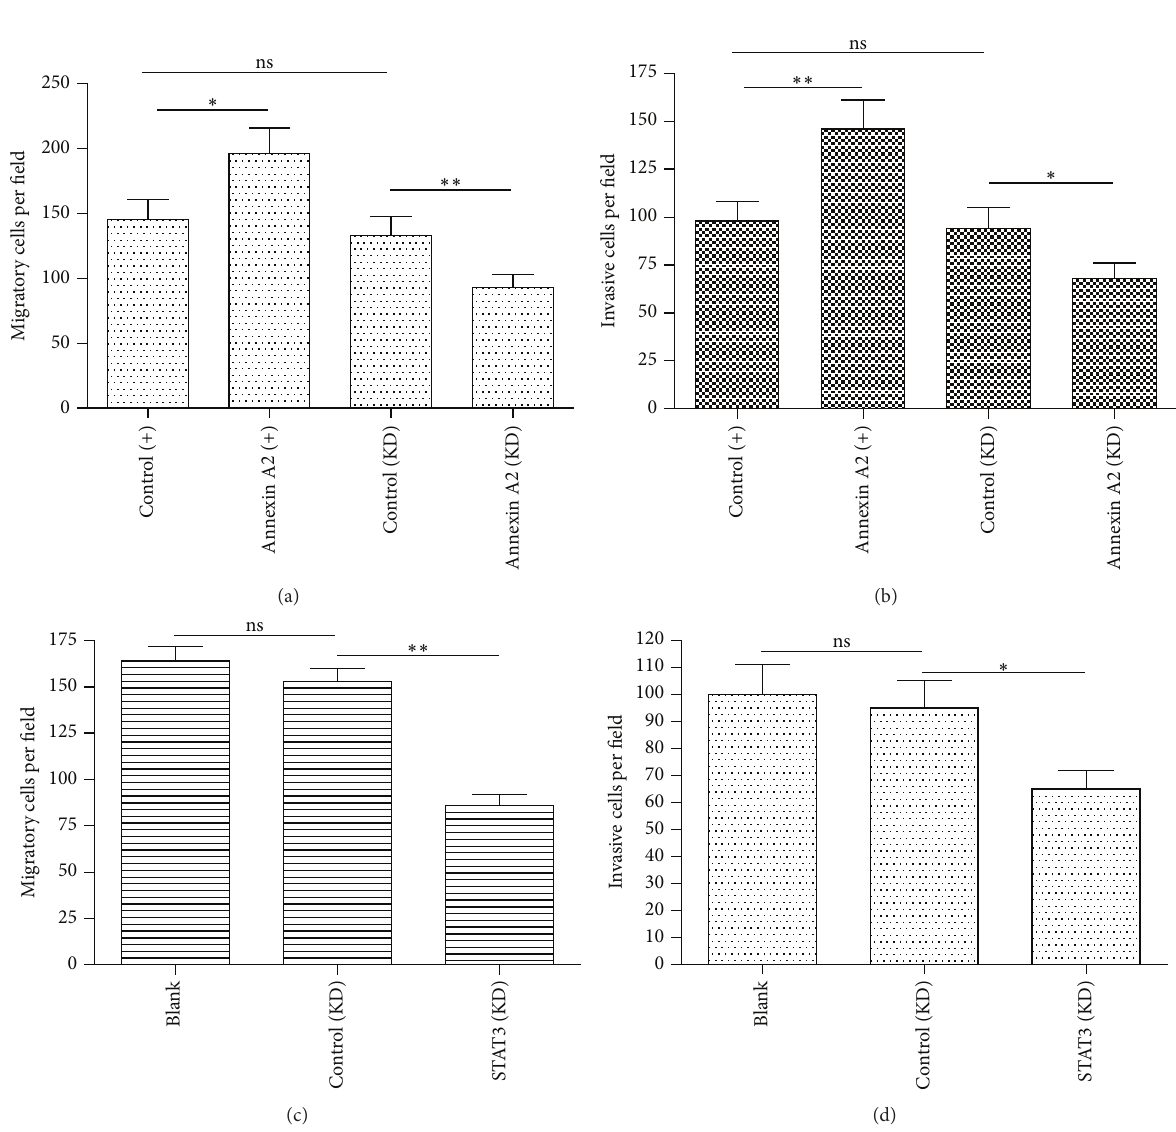
Figure 5: Annexin A2 and STAT3 regulate the migration and invasion of CRC Caco-2 cells. The number of Caco-2 cells was calculated to compare the differences in migration and invasion of Caco-2 cells with indicated treatments by using transwell migration/invasion assays. The effects of Annexin A2 on cells migration (a) and invasion (b) and the effects of STAT3 on cells migration (c) and invasion (d) were indicated, respectively. The three individual experiments were performed. Statistical significance was shown as ∗ 𝑝 < 0.05 and ∗∗ 𝑝 < 0.01